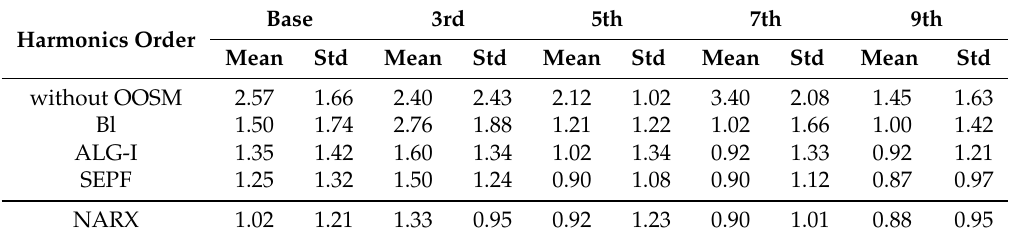
Figure 10. Relative errors of the 3rd harmonic identification with different OOSM methods of different channels. Table 3. Mean square errors of the non-stationary harmonic measurement accuracy